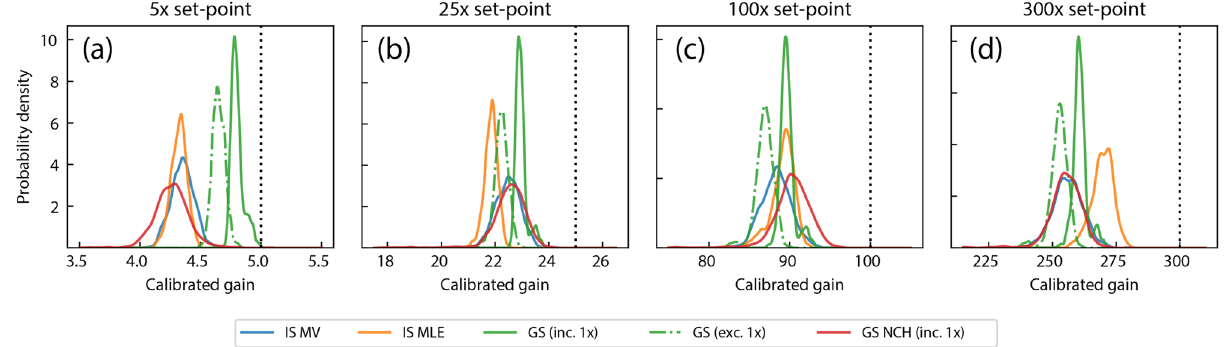
Figure 3. Results from gain calibration methods. Distributions of the gain parameters for ( a ) 5×, ( b ) 25×, ( c ) 100×, and ( d ) 300× set-points are shown for the MV test (blue), intensity series MLE (orange), gain series MLE (green), and MAP of the gain series using a hierarchical model (red). Each method produced differing estimates of the gain parameters. Estimates from each method were significantly smaller than the software set-points (dotted